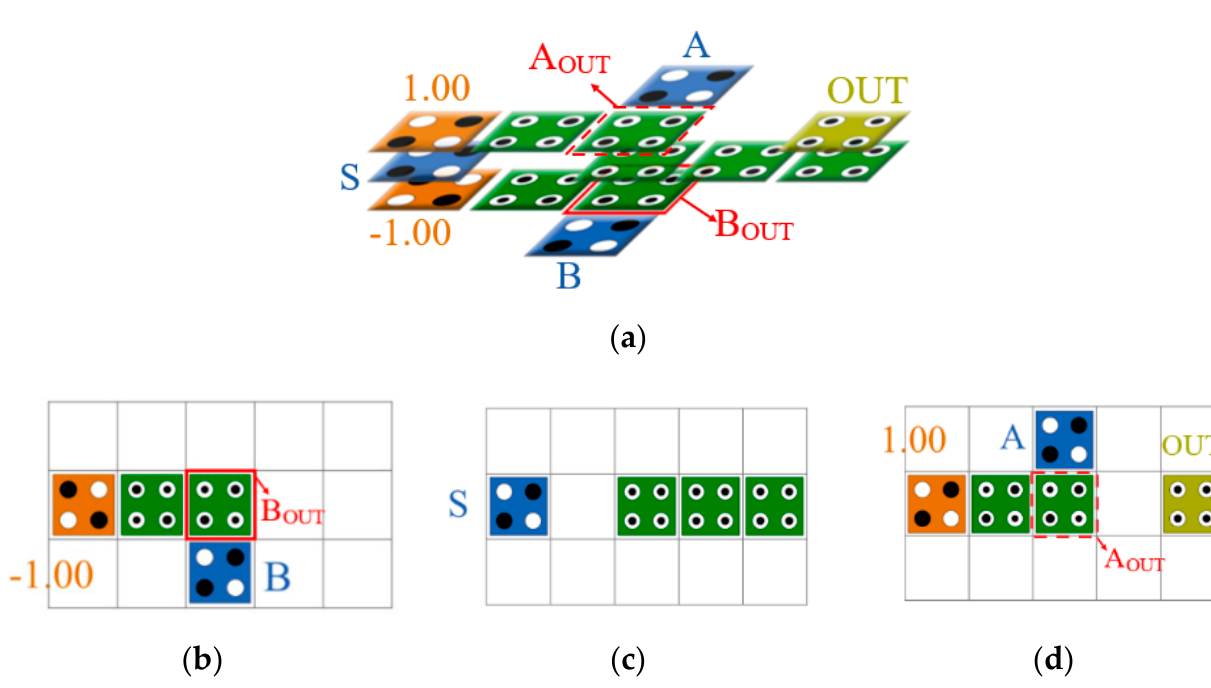
Figure 10. Proposed 2-to-1 Multiplexer: ( a ) full circuit; ( b ) layer 1; ( c ) layer 2; and ( d ) layer 3.